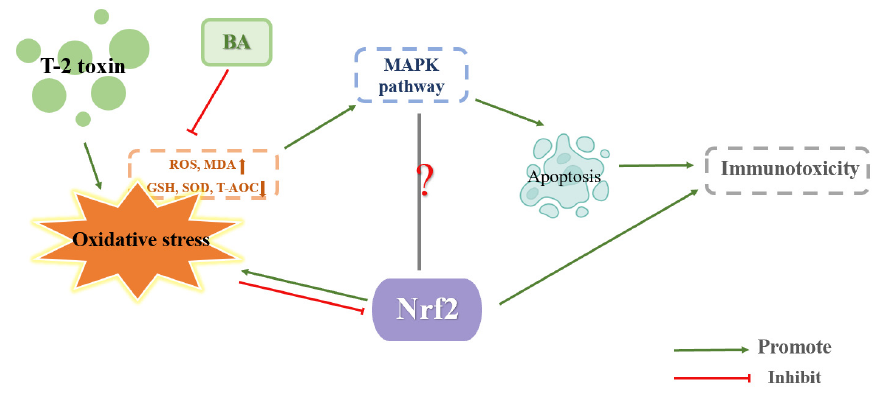
Figure 5. Mechanism of immunotoxicity induced by T-2 toxin.